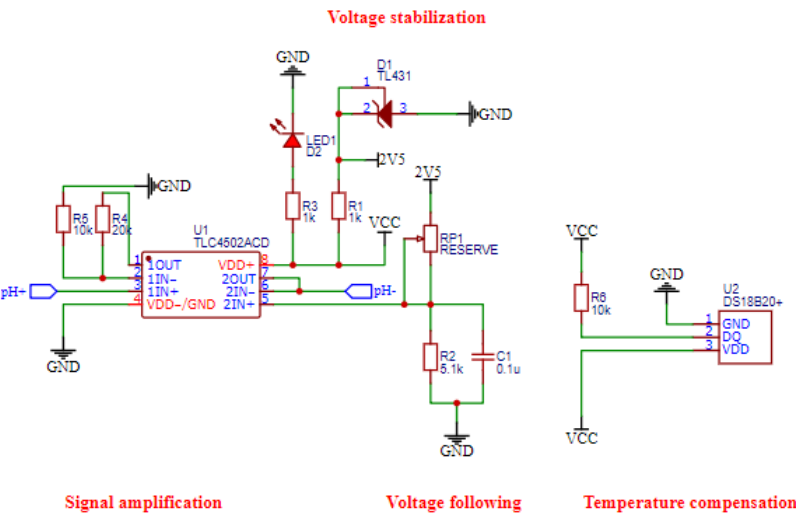
Figure 5. Data acquisition circuit: The number stands for the pin.